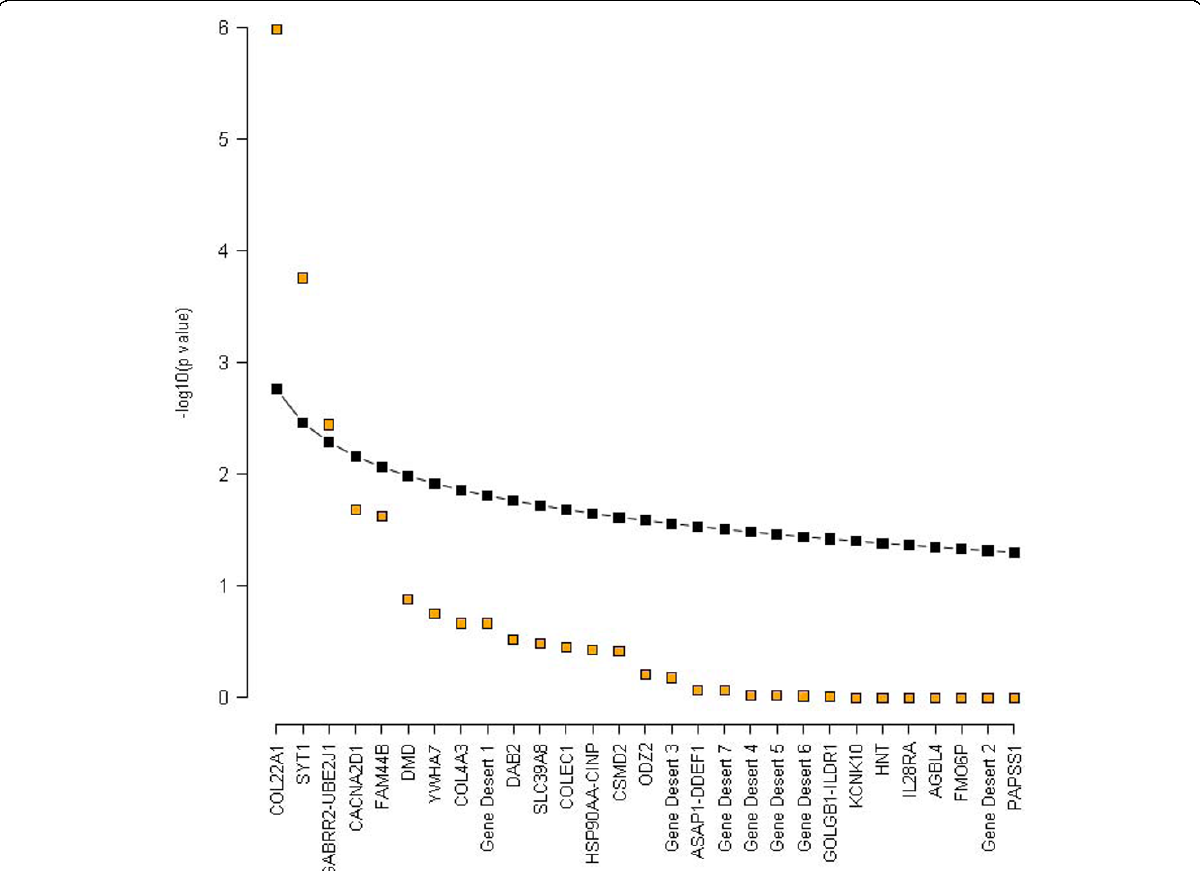
Figure 3 Results of the false discovery rate analysis . -log 10 (Fisher p value) of the replication analysis (orange) and -log 10 (significance thresholds) for FDR (black) are plotted for each candidate locus. According to [41], FDR thresholds have been calculated as i/m × a , with a = 0.05, m = no. of test (i.e.: no. of regions, 29), and i ranging between 1 and 29. After sorting the Fisher p values in ascending order, the first k tests for which the p value is ≤ threshold are